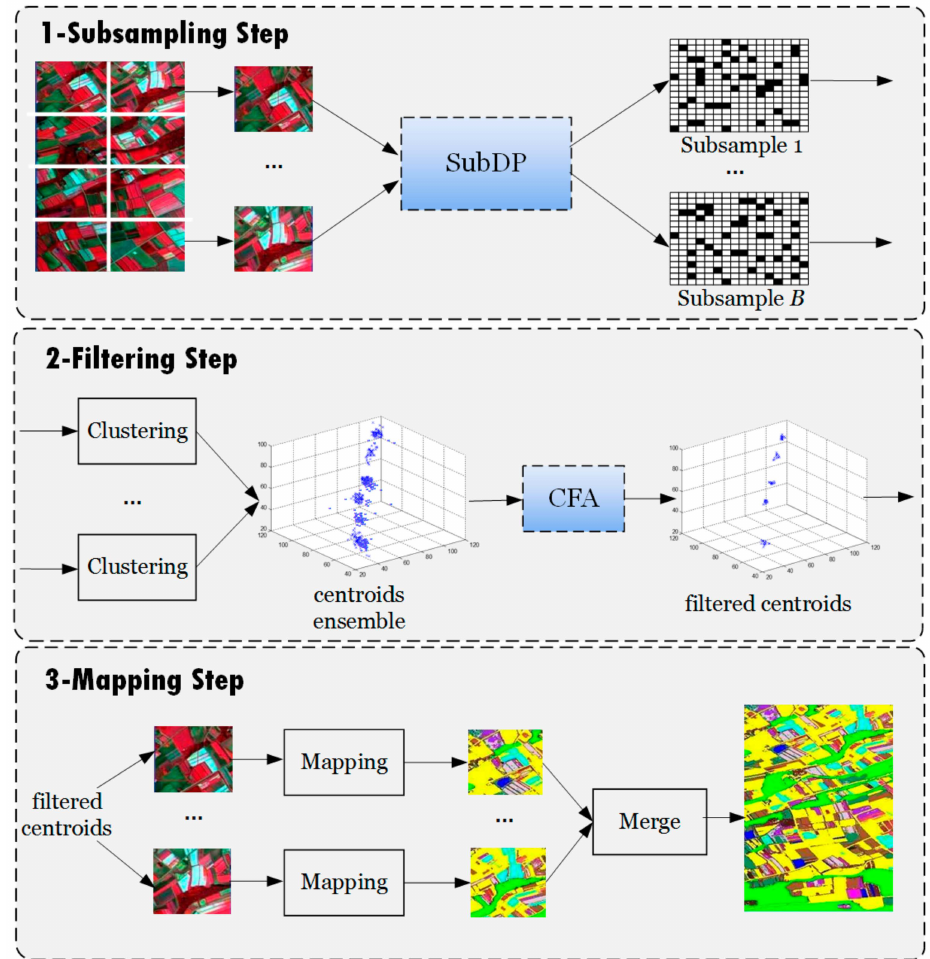
Figure 1. Framework of parallel subsampling-based clustering